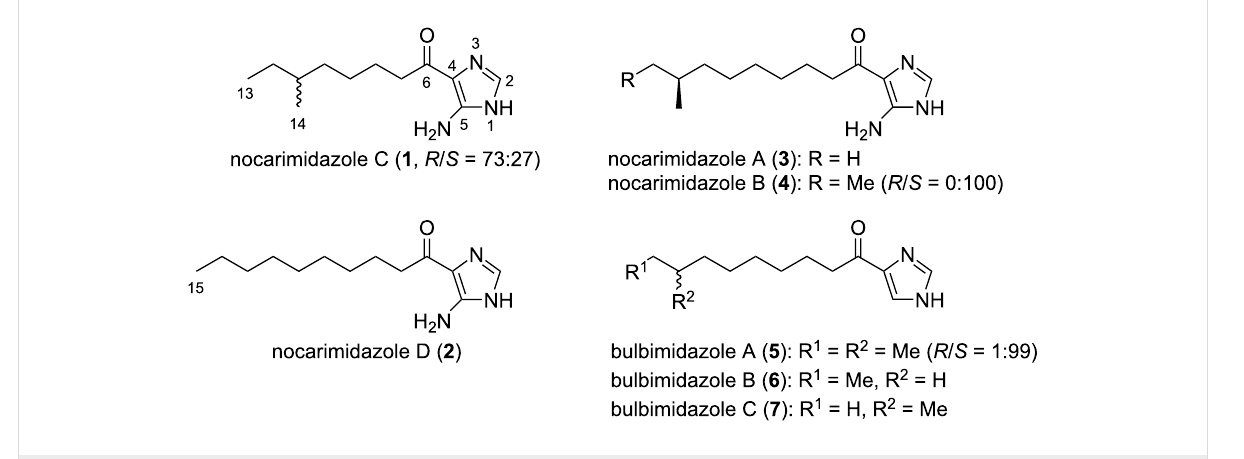
Figure 1: Structure of the nocarimidazoles 1 – 4 and the bulbimidazoles 5 – 7 .